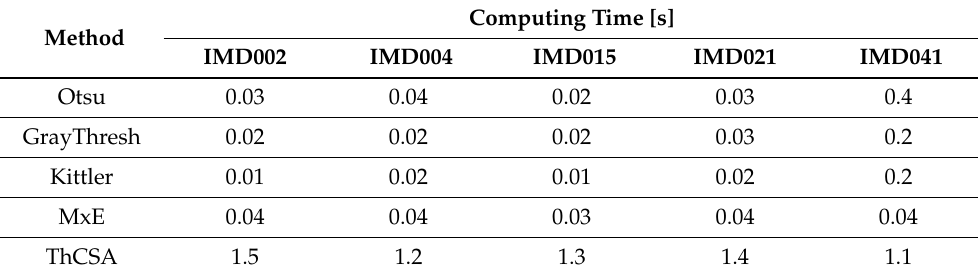
Table 5. Computing time required to find the threshold for medical images with different